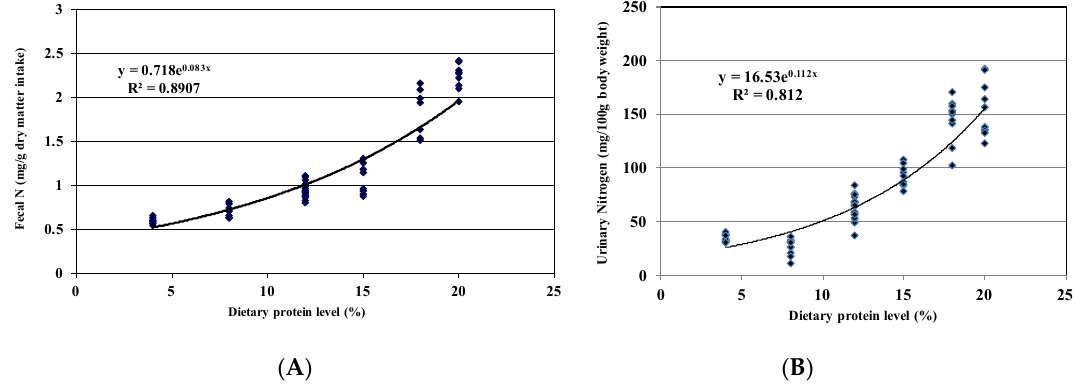
Figure A1. Fecal and urinary endogenous Nitrogen excretion calculated by a regression methodology using different dietary protein levels. ( A ) Endogenous fecal N excretion expressed as mg N per gram of dry matter intake. ( B ) Endogenous urinary excretion expressed as mg N per 100 g of body weight.